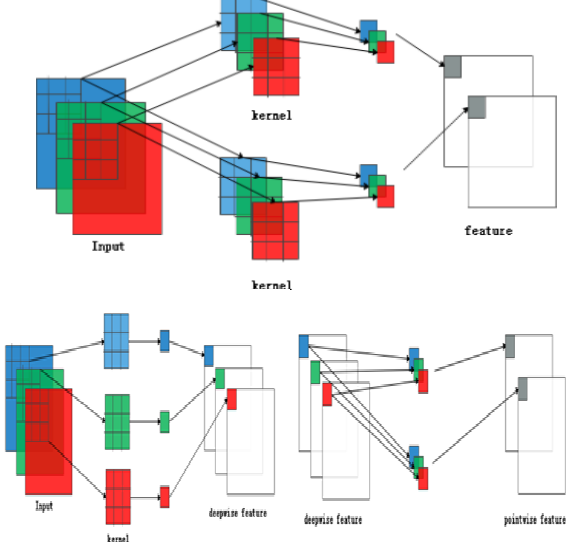
Figure 2. Detailed steps for standard and depthwise separable